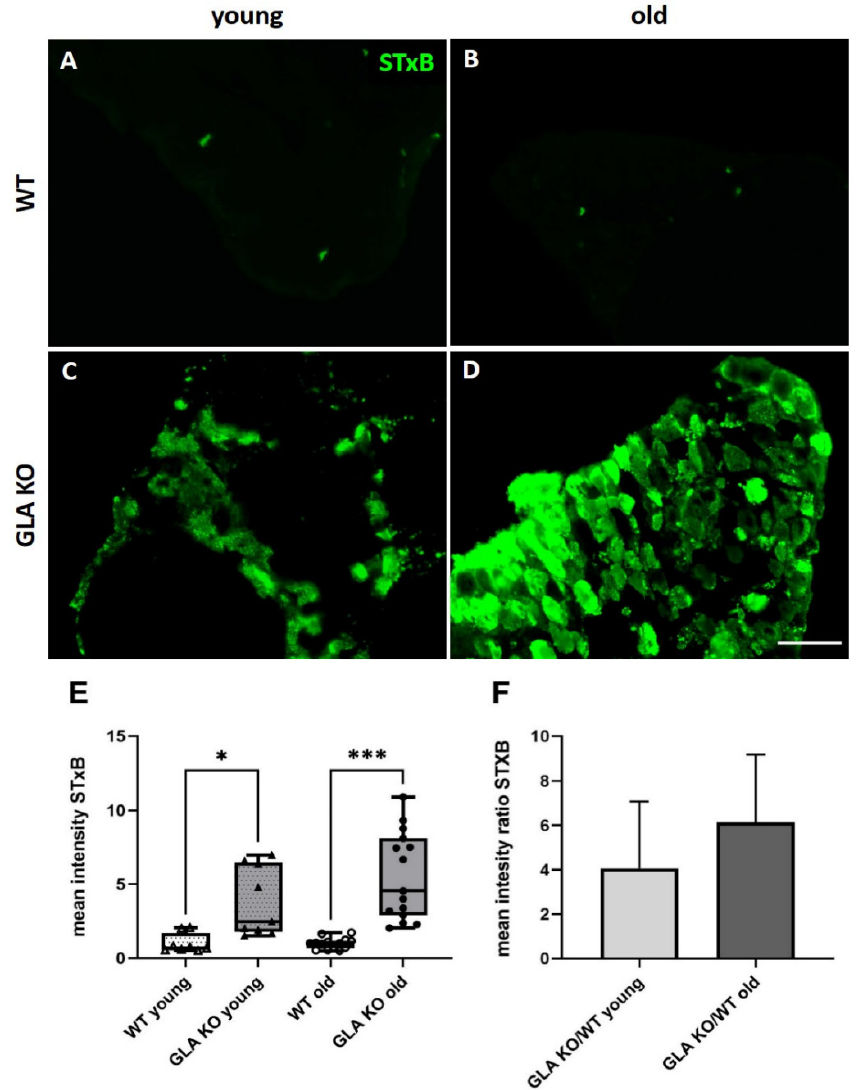
Figure 1. Mean intensity of STxB::555 in murine DRG. ( A – D ) Representative photomicrographs of Gb3 accumulations in DRG of young WT ( A ), old WT ( B ), young GLA KO ( C ), and old GLA KO mice ( D ) visualized with STxB::555 (green). ( E ) Intensity measurements of STxB::555 signal in murine DRG of young WT ( , n = 8), young GLA KO ( , n = 9), old WT ( , n = 14), and old GLA KO mice ( , n = 15). ( F ) Mean intensity GLA KO/WT ratio of STxB::555 signal for young and old murine DRG. Abbreviations: DRG = dorsal root ganglion; GLA KO = alpha-galactosidase A knockout; STxB = Shiga toxin 1, subunit B; WT = wildtype. Scale bar: 100 µm. * p < 0.05, *** p < 0.001.